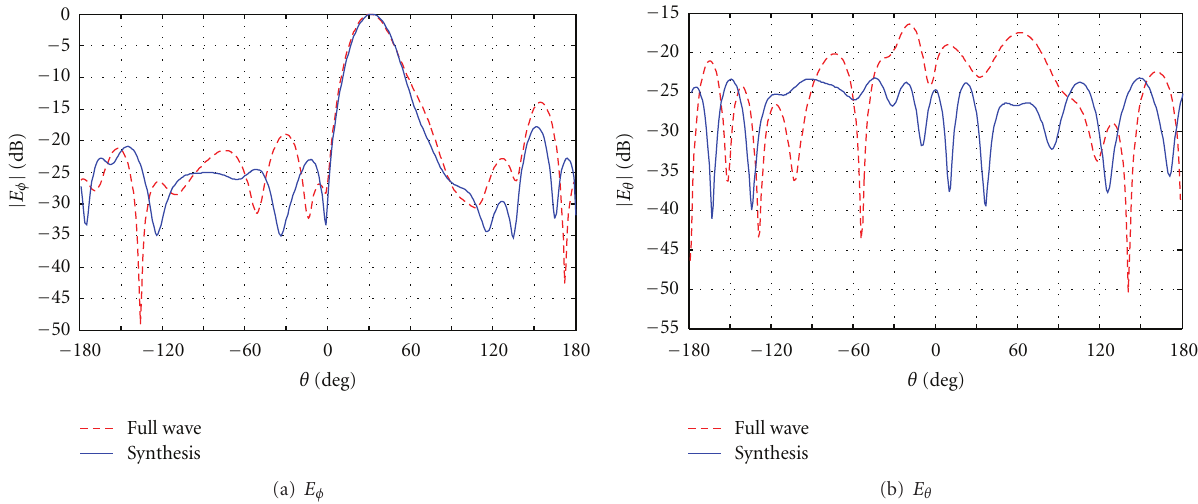
Figure 7: A comparison of the realized pattern using the proposed hybrid method and the simulated by CST without considering of the mutual coupling in the planes ϕ = 90 and ϕ =